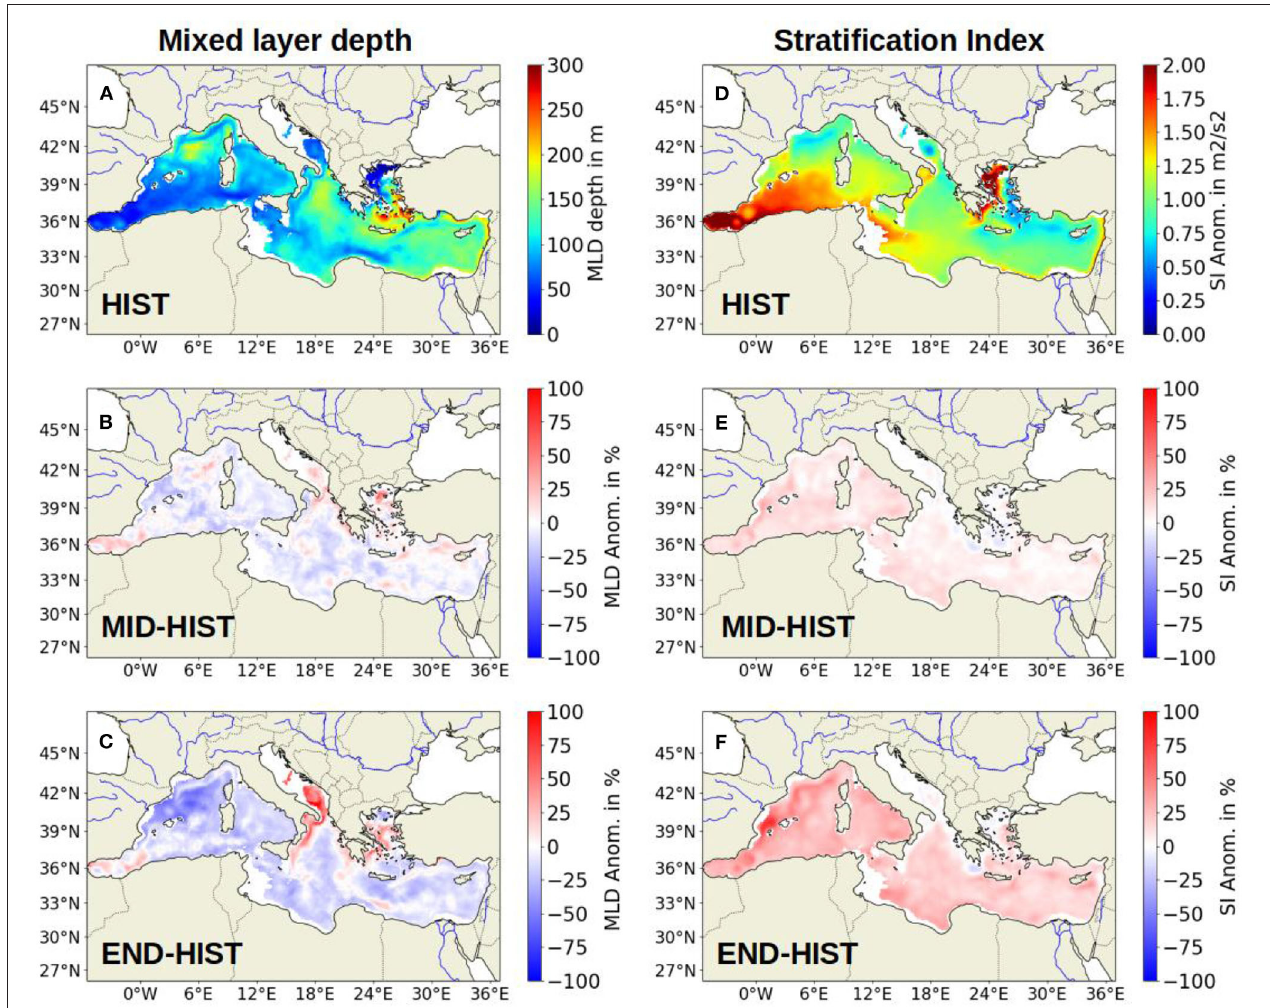
FIGURE 3 | (A) Map of the winter Mixed Layer Depth (MLD) in m during the HIST period; (B) Map of the evolution of the modeled winter (January to March) MLD in percent between HIST and MID (the difference MID - HIST is plotted); (C) Map of the change in the modeled winter MLD in percent between HIST and END; (D) Map of the summer Stratification Index (SI) in m 2 · s − 2 during the HIST period; (E) Map of the change of the modeled SI in percent between HIST and MID; (F) Map of the change of the modeled SI in percent between HIST and